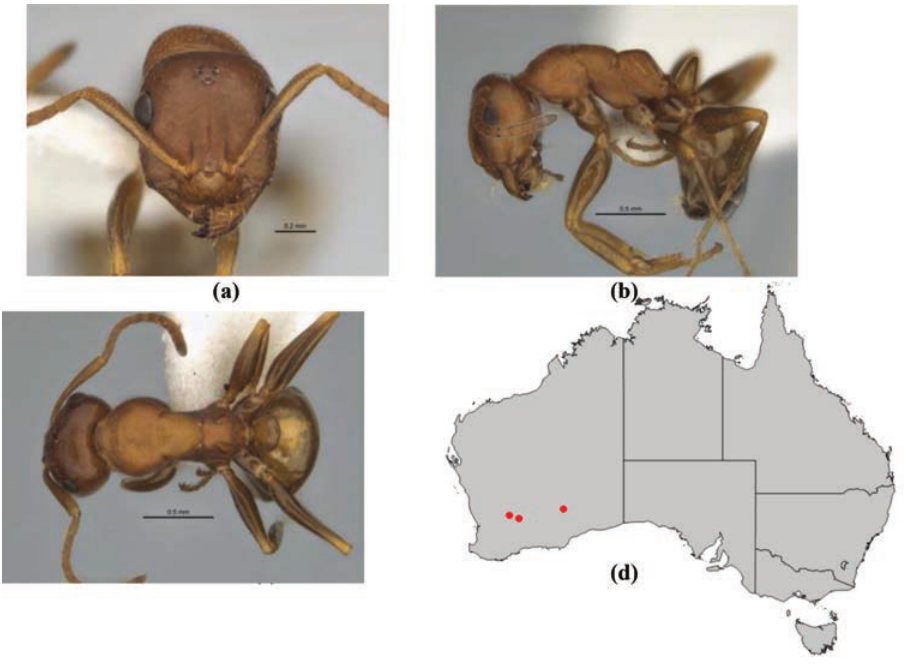
Figure 96. Melophorus macroschismus sp. n.: minor worker holotype (JDM32-001578) frons ( a ), profile ( b ) and dorsum ( c ); distribution map for the species ( d ). Low resolution scale bars: 0.5 mm ( b, c ); 0.2 mm ( a